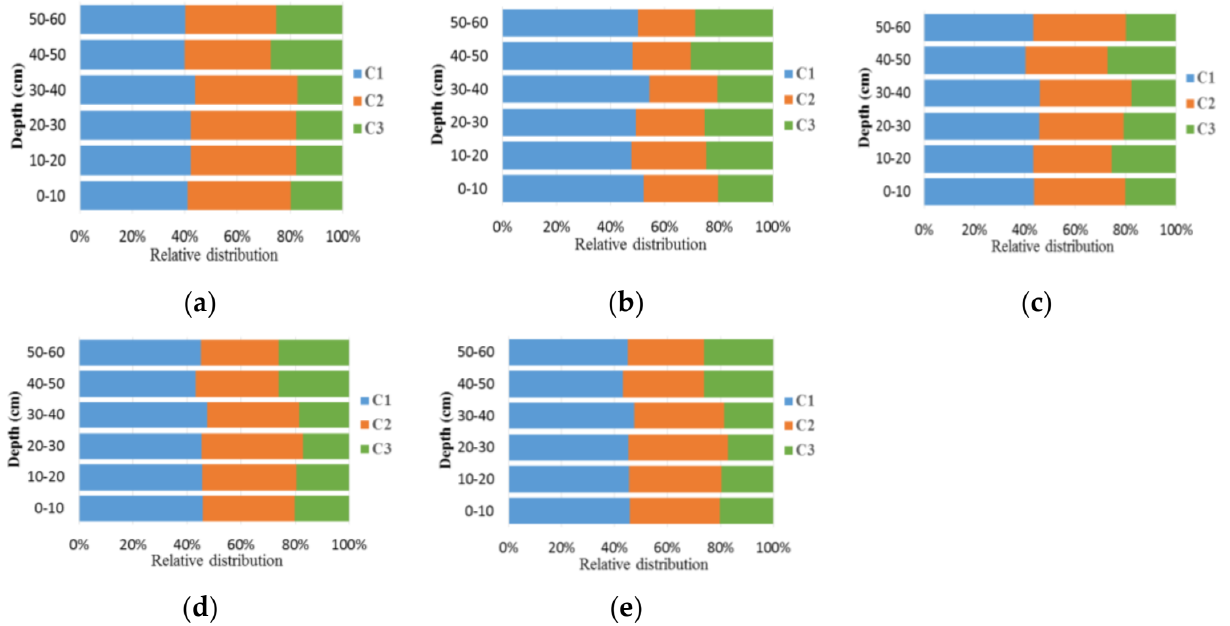
Figure 3. Relative abundances of the three fluorescence components (C1, UVA humic-like substance; C2, UVC humic-like substance; and C3, tyrosine-like (protein-like) substance) estimated by PARAFAC modeling in 0–60 cm soil layers with different fertilizer input for six years: ( a ) CK; ( b ) NPK; ( c ) BC; ( d ) NPK + BC; ( e ) N +